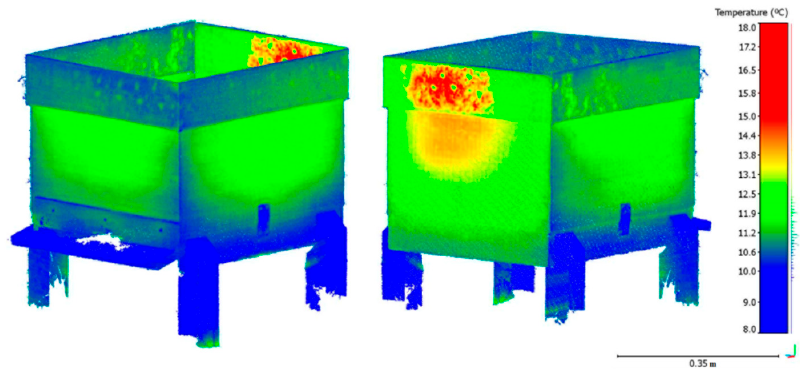
Figure 3. 4D point cloud with thermographic texture of one beehive. Front and right sides ( Left ). Back and left sides ( Right ).